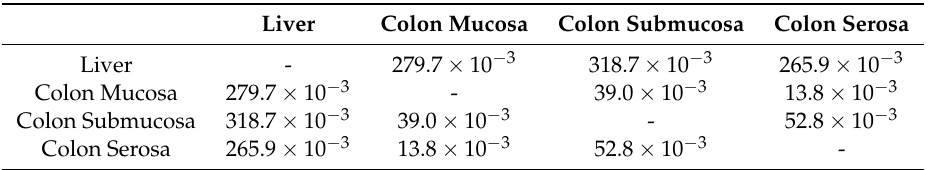
Table 2. Variation (sensibility) of the peak